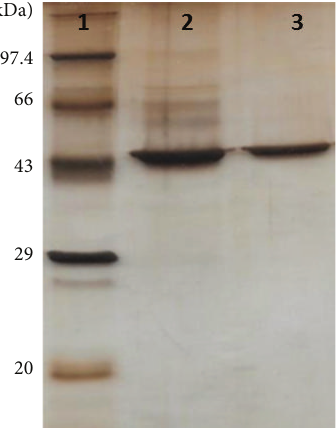
Figure 3: Silver stained SDS-PAGE analysis of purified recombinant rST3Gal-I. Lane 1: protein Molecular weight marker from Merck; lanes 2 and 3: purified recombinant ST3Gal-I protein (2 𝜇 g and 1 𝜇 g, resp.).